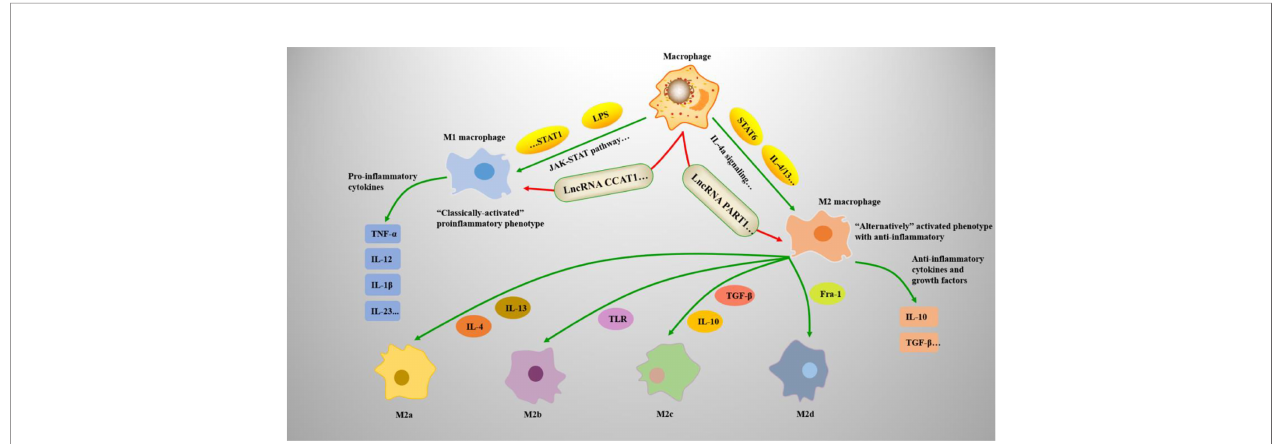
FIGURE 1 | M j s polarization mechanisms and types. M j s adopt a proin fl ammatory M1 phenotype or anti-in fl ammatory M2 phenotype. (1) Under the action of the JAK-STAT pathway, STAT1 dimerizes and reacts with interferon (IFN)- g to induce M1-associated genes, such as TNF- a and IL-12. Lipopolysaccharide (LPS) also induces M1-associated genes by forming the IFN-stimulated gene factor 3 (ISGF3) complex. (2) IL-4, IL-13, and STAT6 are associated with M2 M j polarization. STAT6 mediates IL-4a signaling and regulates M2-associated genes, such as IL-10 and TGF- b ; (3) the M2 phenotype can differentiate into M2a, M2b, M2c, and M2d under the induction of related